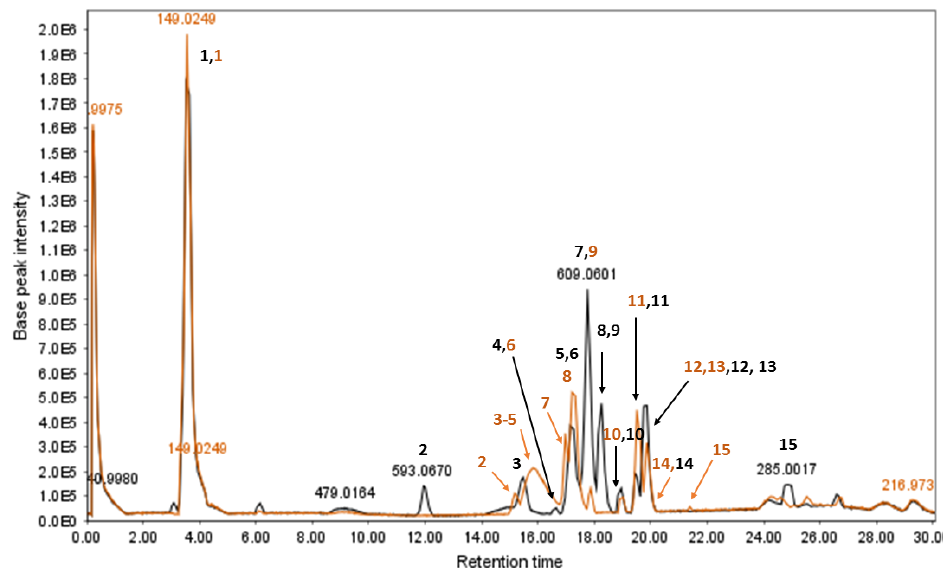
Figure 7. HPLC-ESIMS chromatographic profile of S. italica (orange) and S. alexandrina (black) 100% MeOH extracts. ESIMS: base peak chromatogram (BPC), negative ion mode, m / z 150–1500. The compounds were identified by comparing their LC/ESIMS characteristics with literature. Peaks 10s are sennoside A in both samples. Peaks 4 is sennoside B in sample S. alexandrina , and peak 6 in sennoside B in S. italica . E5: 10 5 , E6: 10 6 . (For interpretation of the references to color in this figure legend, the reader is referred to the web version of this article.)